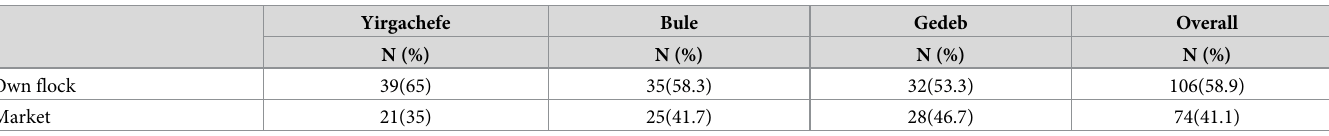
Table 6. Sources to replace breeding ram.